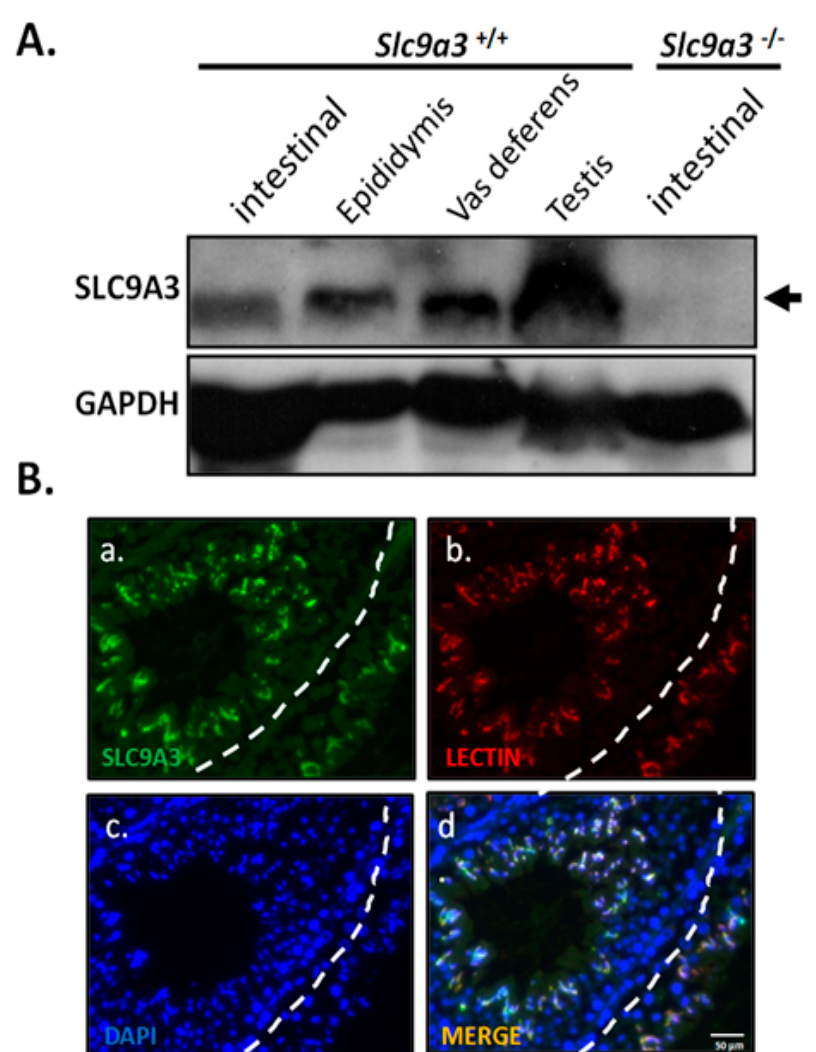
Figure 1. Solute carrier family 9 isoform 3 (SLC9A3) expression in the murine testis ( A ) SLC9A3 expression in the intestines, epididymides, vas deferentia, and testes of adult wild-type mice was compared with that in the intestines of Slc9a3 − / − mice through western blotting. The upper image shows SLC9A3 expression ( arrow ), and the lower image shows Glyceraldehyde 3-phosphate dehydrogenase ( GAPDH) expression, which was used as a loading control; ( B ) Testis of WT mouse was detected through immunofluorescence staining with anti-SLC9A3 primary antibodies (SLC9A3 signals; green ) ( a ). ( b ) Lectin (acrosome marker; red ) and ( c ) 4 ′ ,6-diamidino-2-phenylindole (DAPI) (nucleus marker; blue ) were costained and are displayed as a merged image ( d ). Scale bar = 50 μ m.